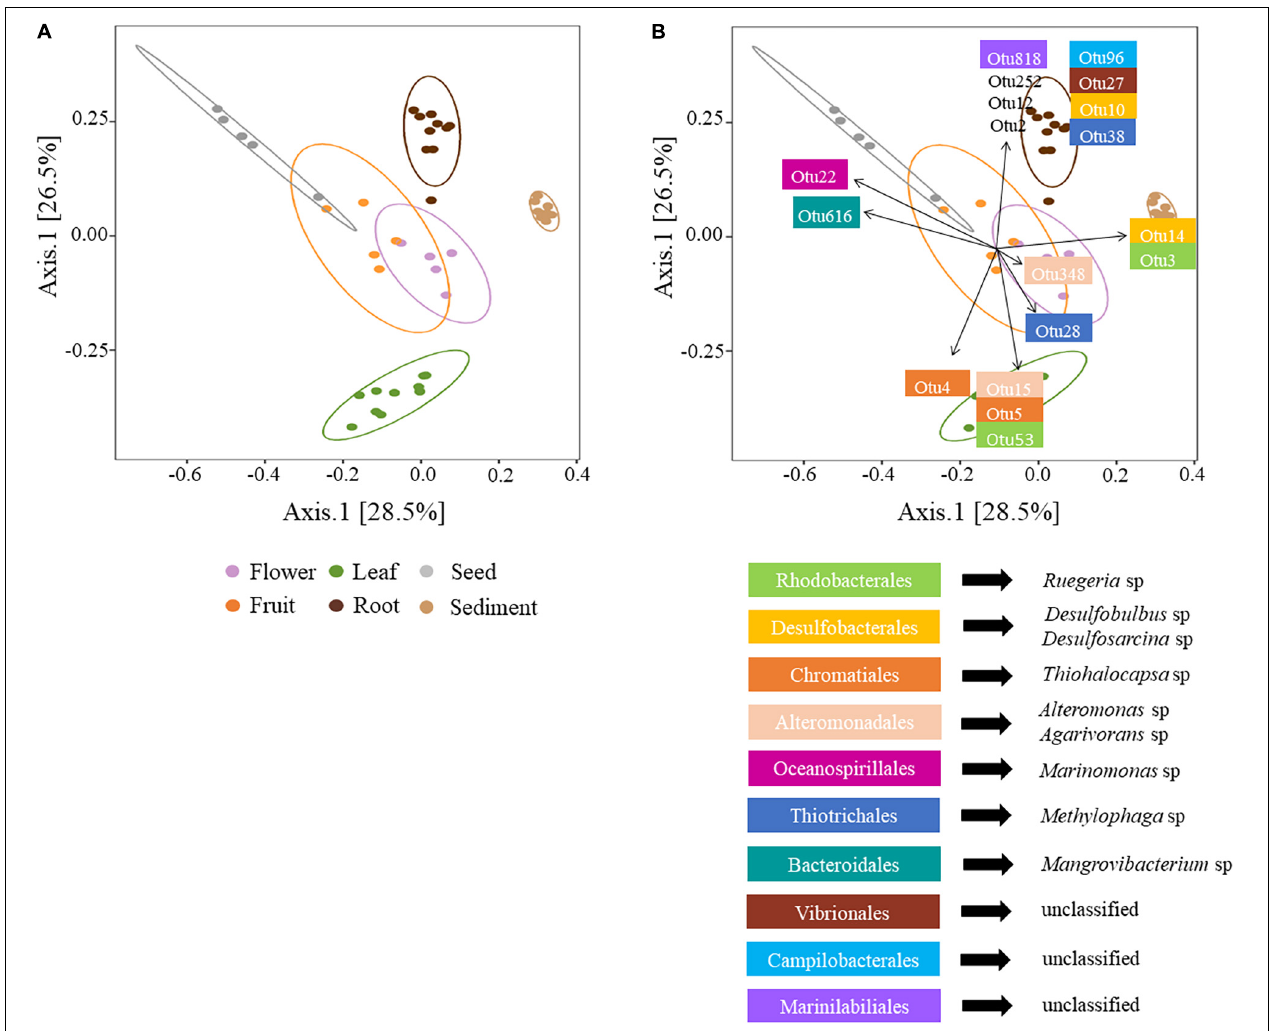
FIGURE 2 | (A) Principal coordinates analysis (PCoA) of microbial communities associated with H. ovalis rhizospheric sediment, roots, leaves, flowers, fruits, and seeds. The percentages in parentheses refer to the proportions of variation explained by each ordination axis. The confidence ellipses (with a 95% confidence level) corresponding to each microenvironment are shown (B) PCoA with envfit object displaying the first two OTUs with the highest contribution to the dissimilarity between pairwise tests from SIMPER. OTUs identity is reported below the PCoA. OTU 2, 12, and 252 are unclassified